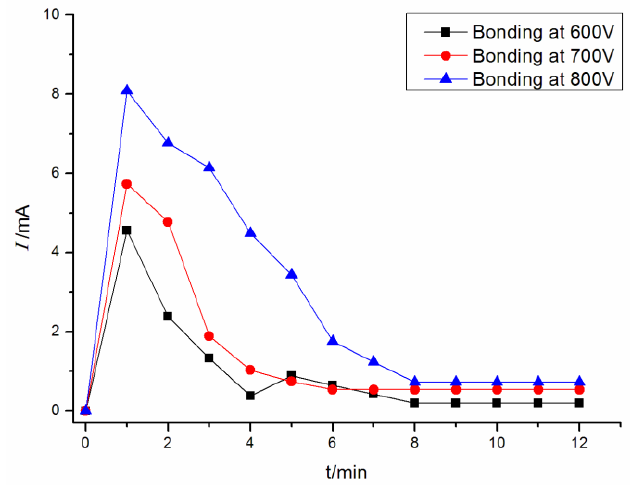
Figure 8. The time – current curve during anode bonding of (PEG) 10 LiClO 4 and Al.